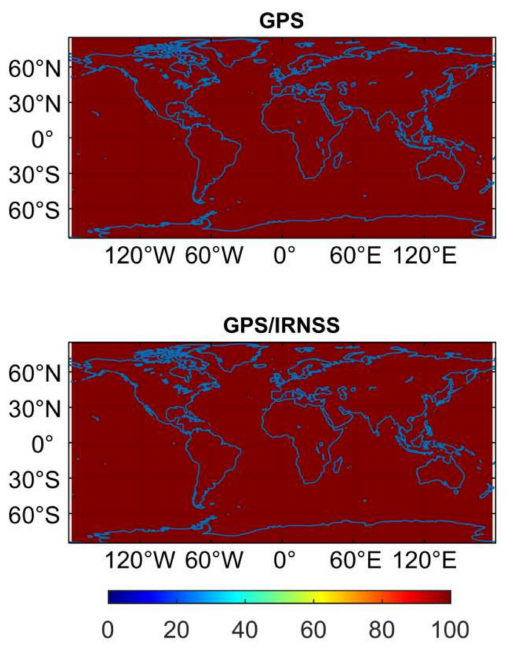
Figure 6. Service rate of GPS-only case and GPS/IRNSS case (unit: